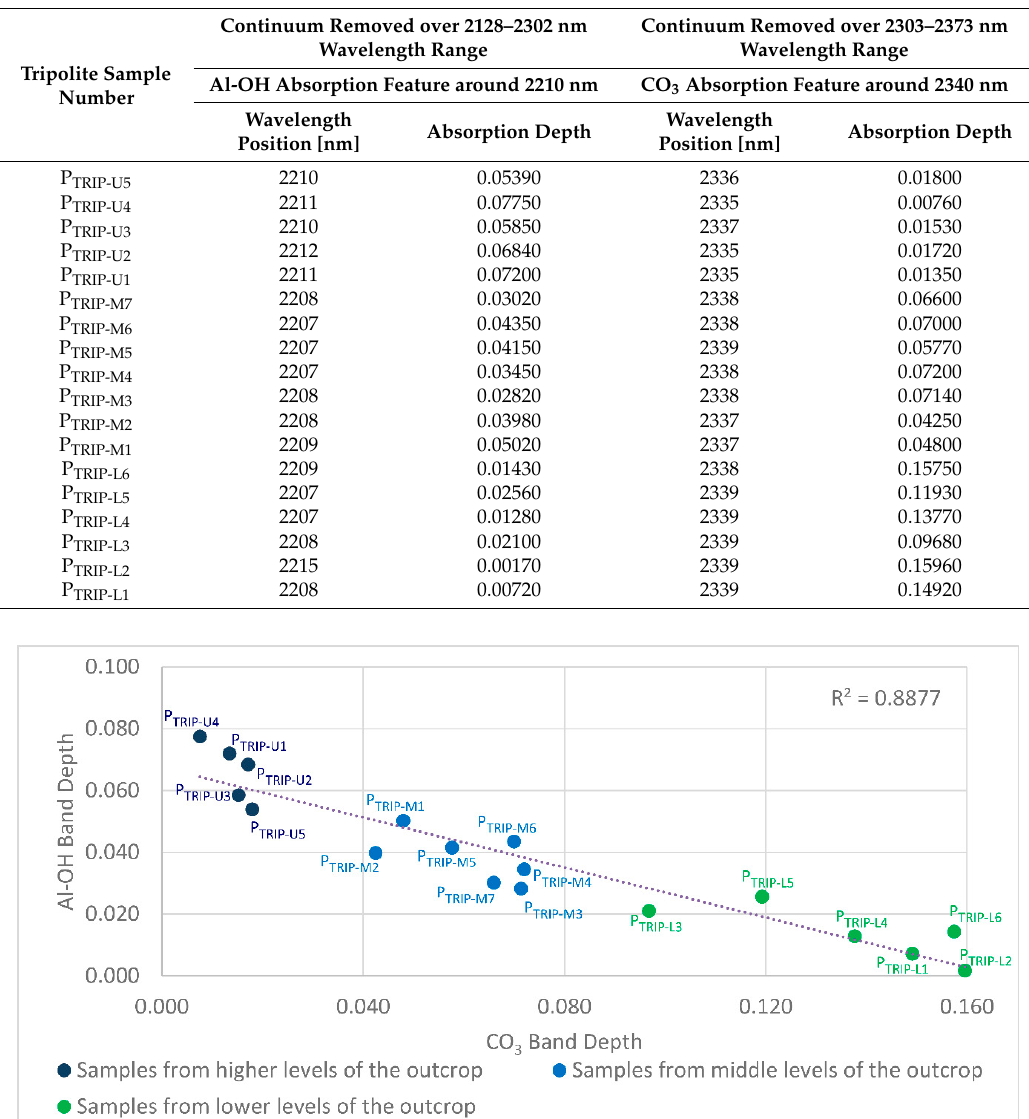
Table 2. Absorption feature parameters (wavelength position and relative depth) of Al-OH and CO 3 obtained from the continuum removed spectra of tripolite samples.